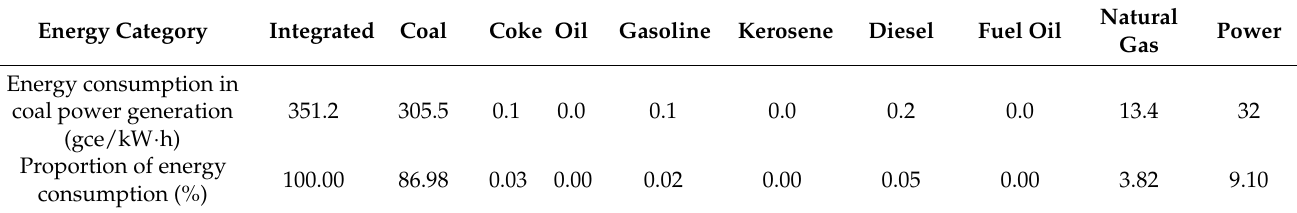
Table 4. Unit energy consumption in coal power plants and the proportion of energy